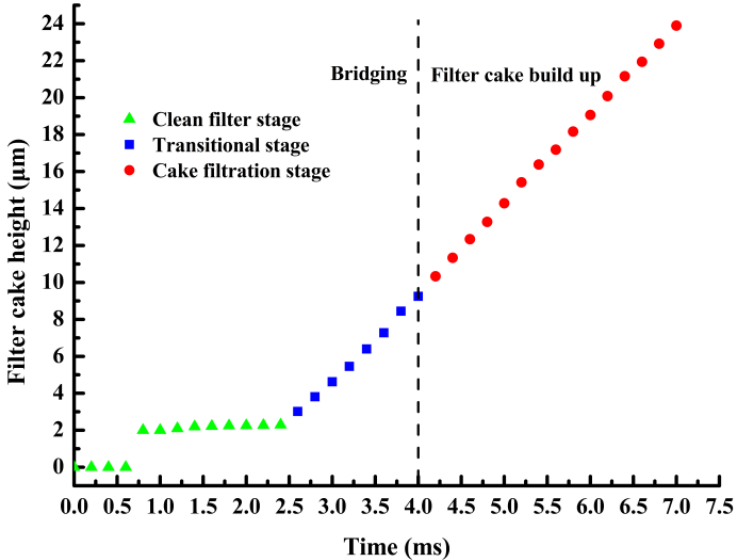
Figure 6. Variation curve of filter cake height with time.